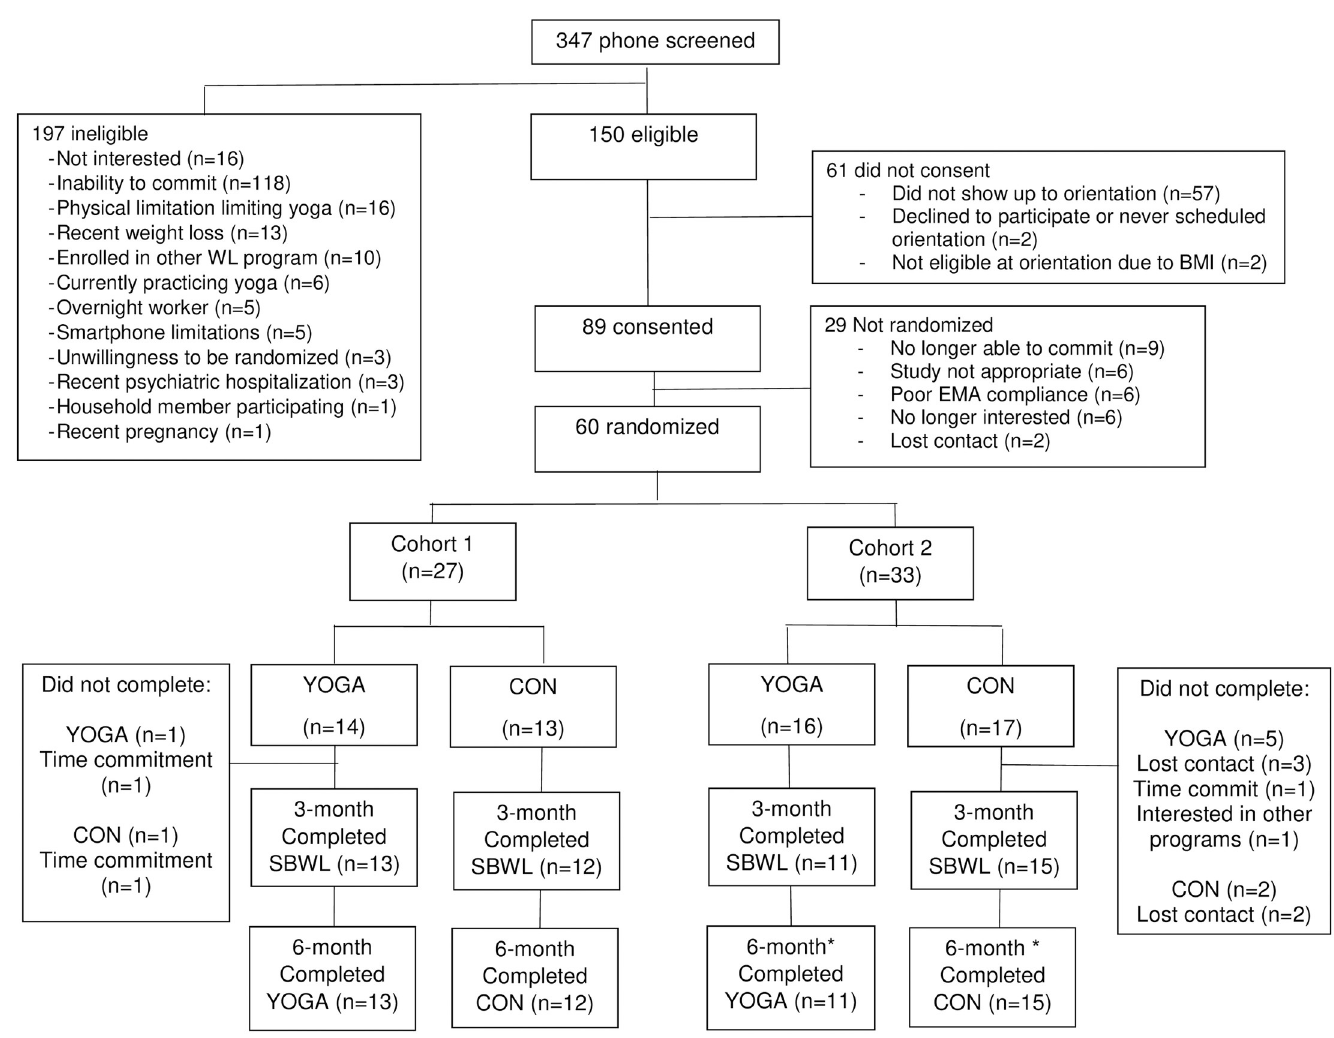
Fig 1. Consort diagram. � While all participants completed the 6-month assessment visit, 1 YOGA and 2 CON participants from Cohort 2 did not continue to participate in the intervention beyond week 6 due to childcare issues as a result of the COVID-19